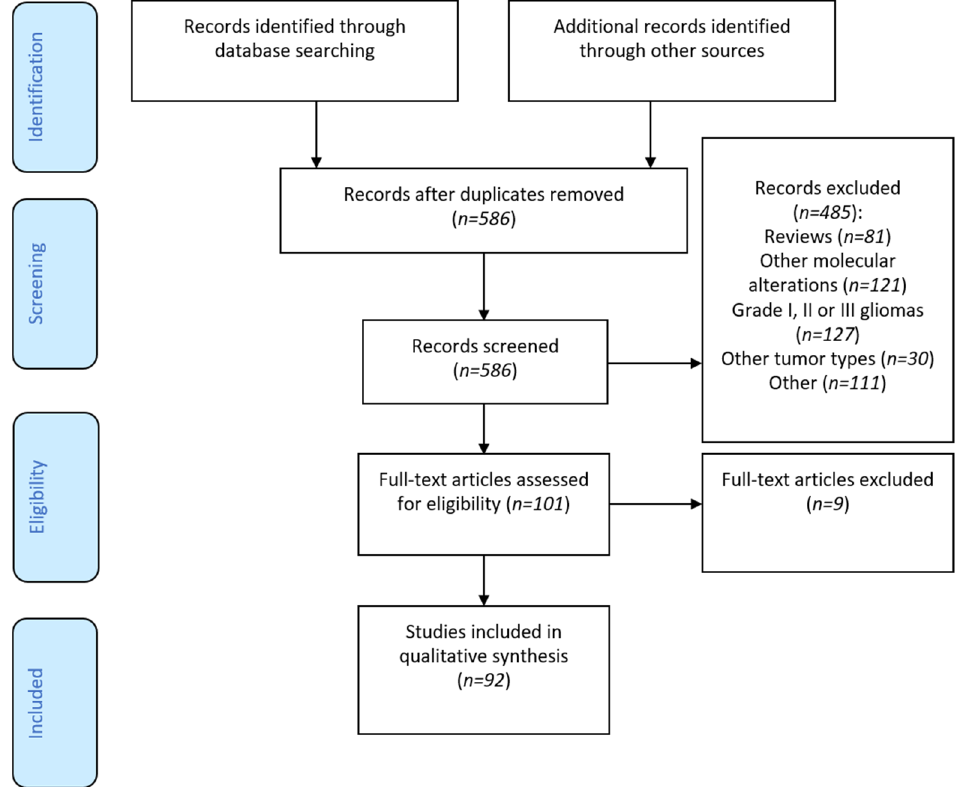
Figure 1. Flow-chart. Figure 1.